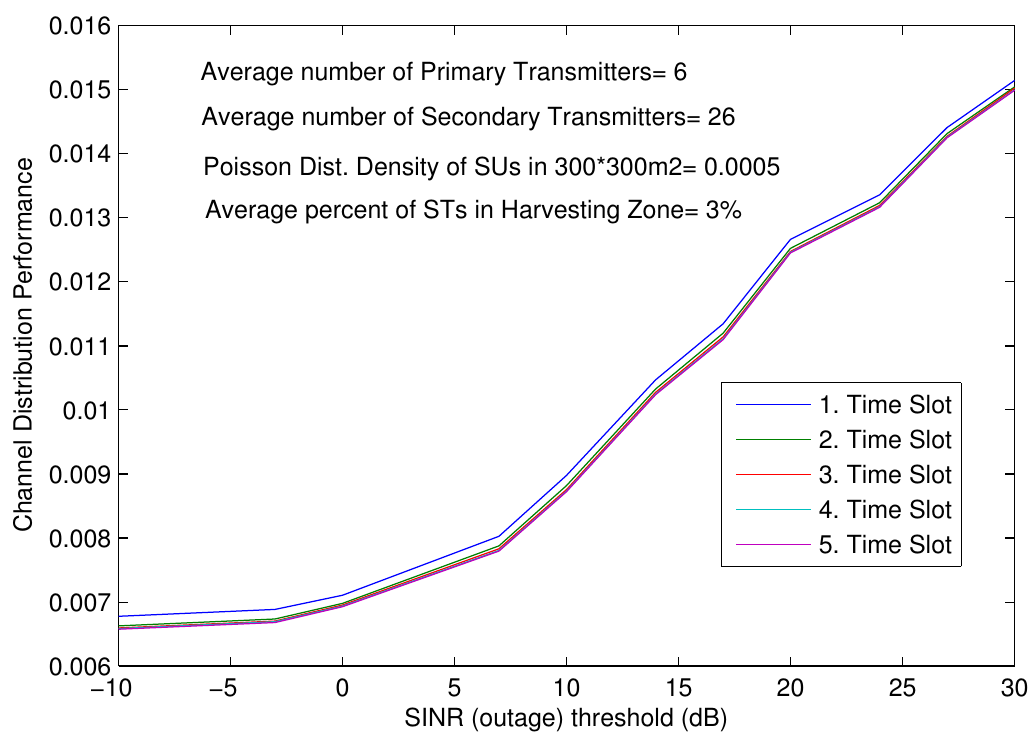
Figure 6. ChDistFairness against different SINR (threshold) values for Poisson distribution density of STs of 0.0005 in an area of 300 × 300 m 2 around the PT and average percentage of STs in harvesting zone of about